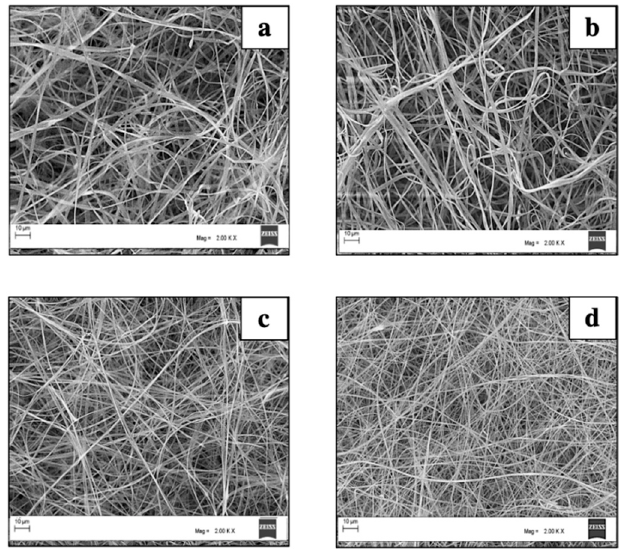
Figure 4. SEM images, at the same magnification (×2000), of electrospun zein fibers loaded with ( a ) 15%, ( b ) 20%, ( c ) 35%, ( d ) 45% SCG extract.